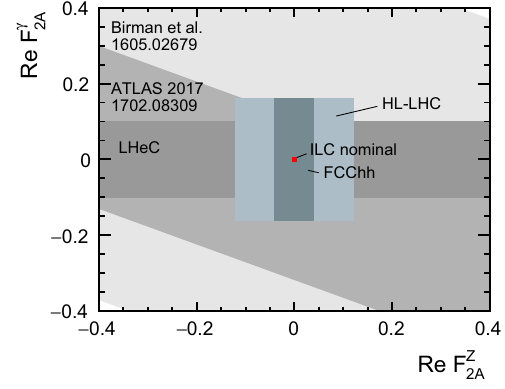
γ Fig. 7 The 68% C.L. limits on Re F Z and Re F derived from mea- 2 A 2 A surements of the Wtb vertex performed by ATLAS and CMS during run I of the LHC. This interpretation assumes that there is a relation between the imaginary part of the anomalous chirality-flipping cou- pling g R that affects the tWb -vertex and the real part of the form factors γ, Z F measured in e + e − → t ¯ t production, as is generally the case in an 2 A effective-operator interpretation. The prospects of future colliders are indicated for